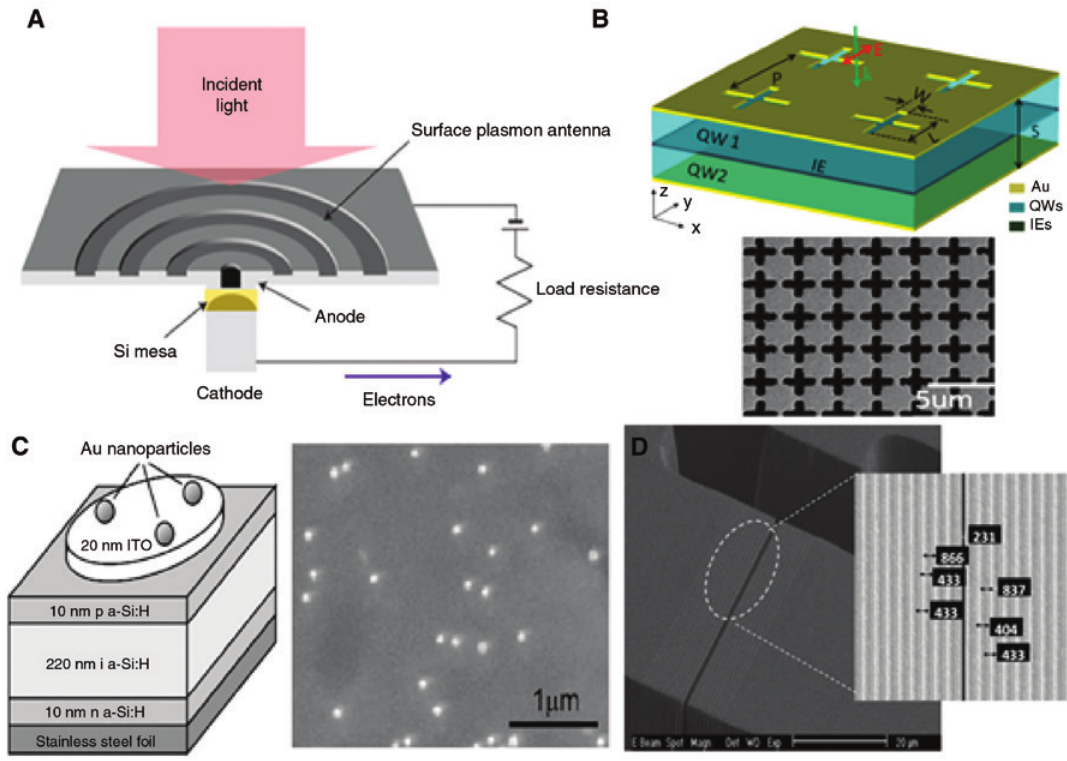
Figure 13: Different types of plasmonic structure: (A) bull’s eyes structure [195], (B) plasmonic arrays [196], (C) nanoparticles-based plas- monic photodetector [197], and (D) single slit EOT structure